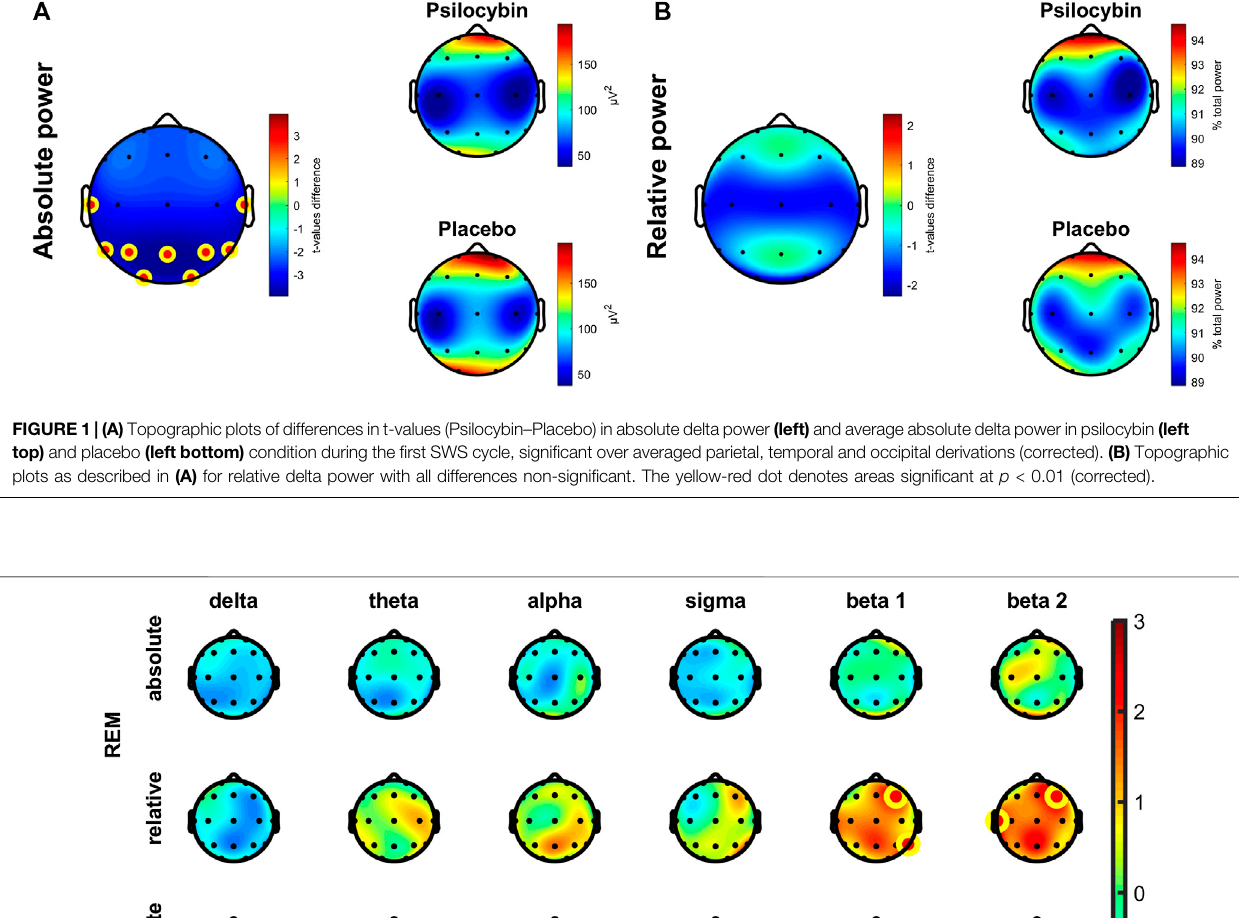
Frontiers in Pharmacology |